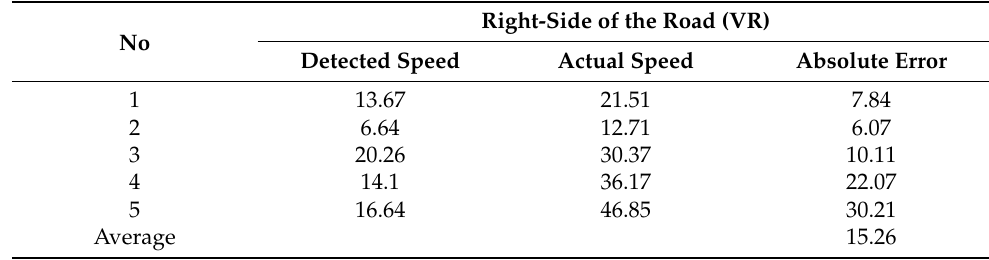
Table 15. Absolute error (km/h) for vehicle speed calculation on Merdeka-Aceh Intersection.